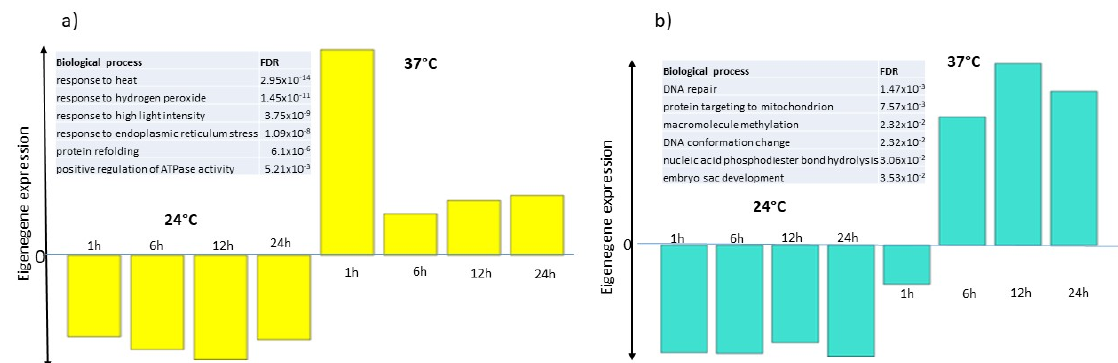
Figure 7. Eigengene expression of the yellow ( a ) and turquoise ( b ) WGCNA modules containing genes up-regulated by temperature increase. The histogram bars represent the eigengene expression of each module in samples grown at 24 °C or 37 °C for 1, 6, 12, 24 h. The GO term enrichment is represented in the left upper part of each figure panel.